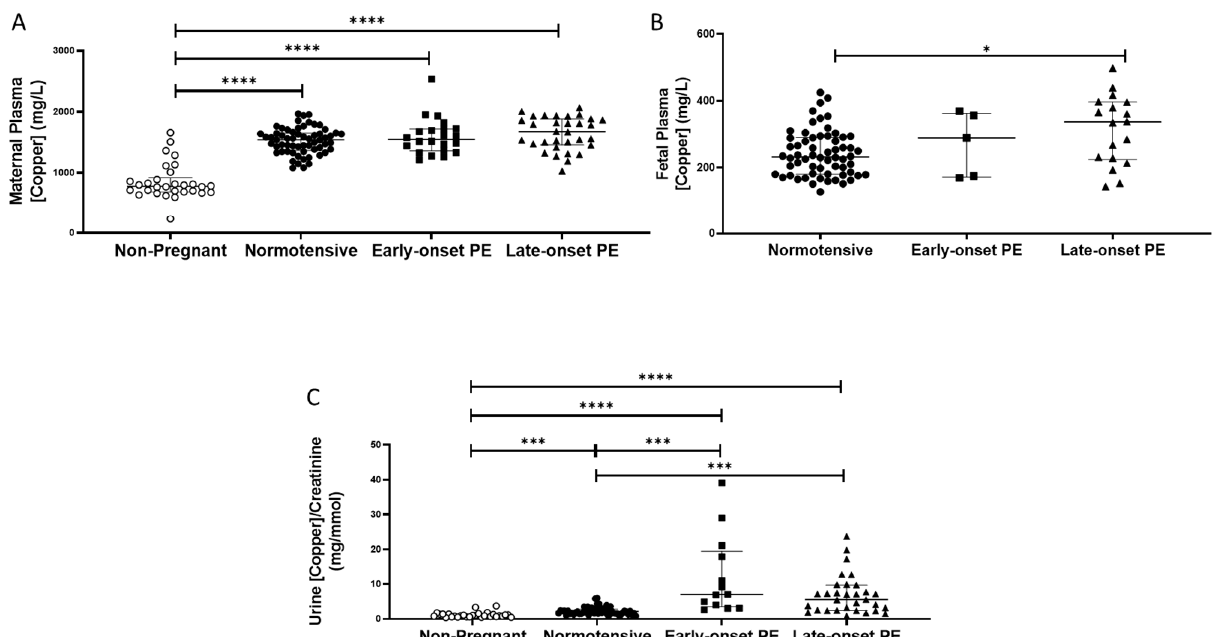
Figure 4. ( A ) Maternal plasma copper concentrations in non-pregnant (n = 30), normotensive pregnant women (n = 60) and those with early- (n = 24) and late-onset (n = 31) pre-eclampsia (PE); ( B ) umbilical cord venous (fetal) plasma copper concentrations in normotensive pregnant women (n = 60) and those with early- (n = 5) and late-onset (n = 18) PE; ( C ) Urinary copper/creatinine concentrations in non-pregnant (n = 28), normotensive pregnant women (n = 60) and those with early- (n = 23) and late-onset (n = 31) PE. Maternal plasma copper levels were significantly higher overall in women with pre-eclampsia than in normotensive women, but only increased in late-onset PE, compared to normotensive controls when spilt. Data presented as median (IQR); * p < 0.05; *** p < 0.001; **** p < 0.0001.